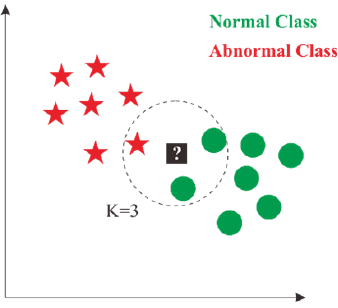
Figure 13. Illustration of KNN